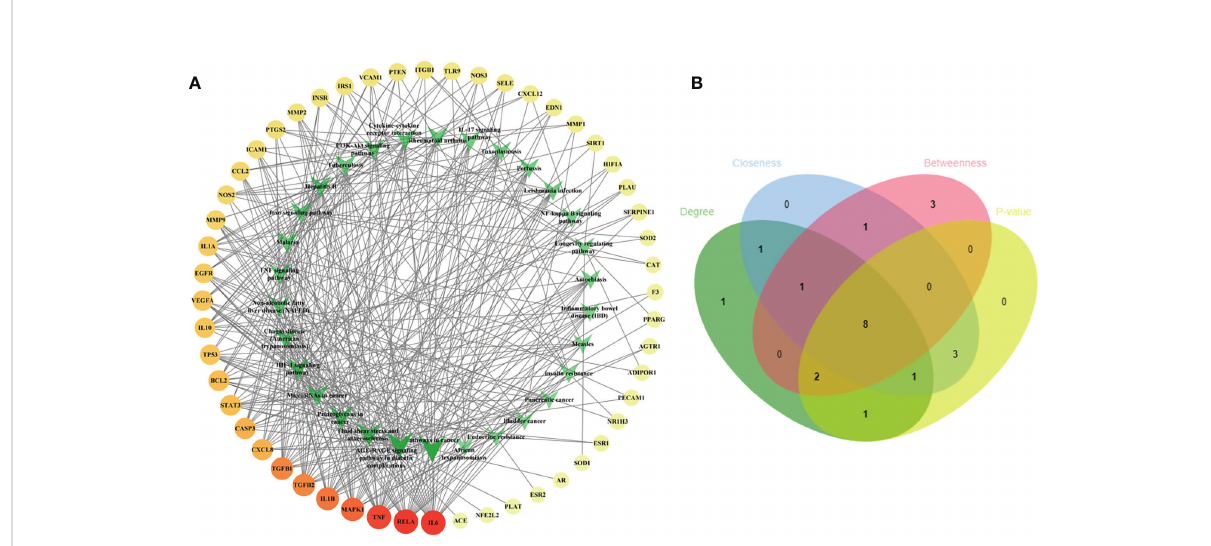
FIGURE 4 The TP network between the 52 intersecting targets of RSV and PE and the top 30 pathways in the KEGG analysis and the topological parameters analysis of the TP network. (A) The TP network between the 52 intersecting targets of RSV and PE and the top 30 pathways in the KEGG analysis. The different colors of circular codes in the outer circle represent the targets. From yellow to red, the score gradually becomes higher. The green V-shaped nodes in the inner circle represent the pathways. The deeper the green node is, the higher its score. (B) The Venn diagram of the top 15 pathways of each topological parameter. Eight pathways located in the central region were the main pathways. The green ellipse represents degree. The blue ellipse represents closeness centrality. The red ellipse represents betweenness centrality. The yellow ellipse represents the fi rst 15 pathways with the least p -value. Eight pathways located in the central region were identi fi ed as the main pathways. TP, target – pathway; RSV, resveratrol; PE, preeclampsia; KEGG, Kyoto Encyclopedia of Genes and